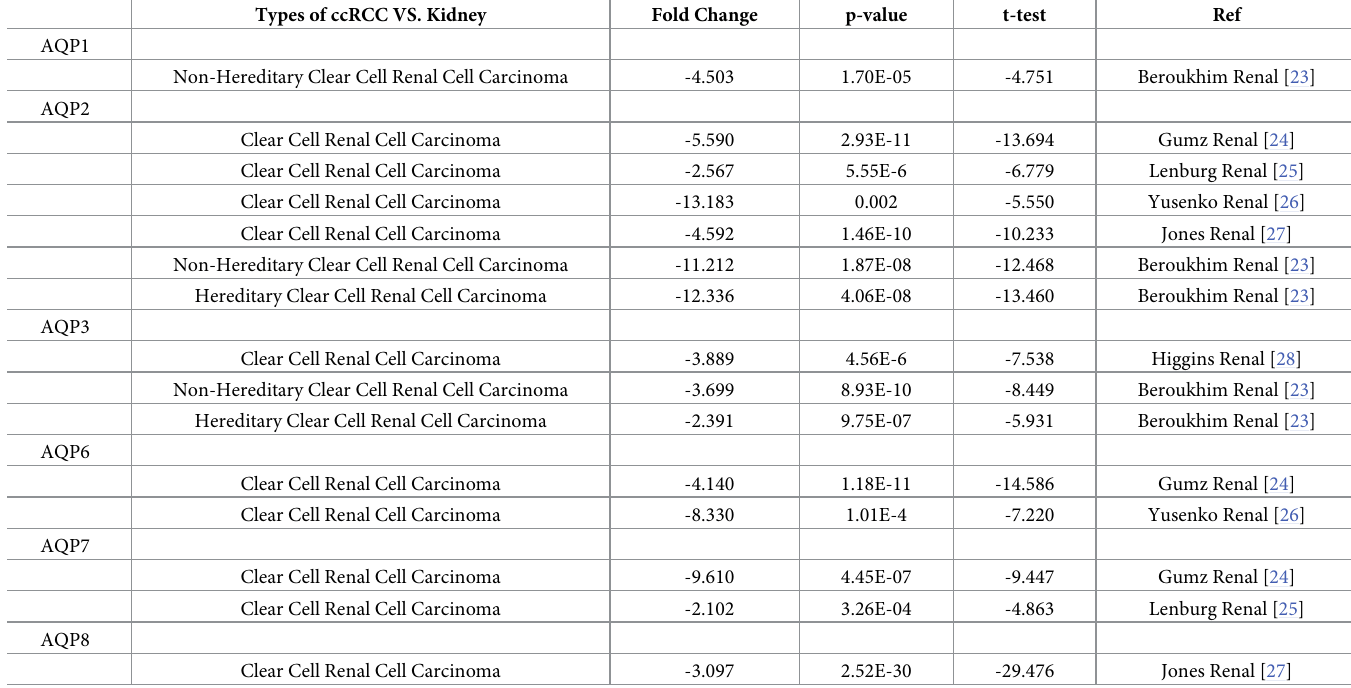
Table 1. Significant changes of AQPs expression in transcription level between ccRCC and normal kidney tissues (Oncomine). Types of ccRCC VS.